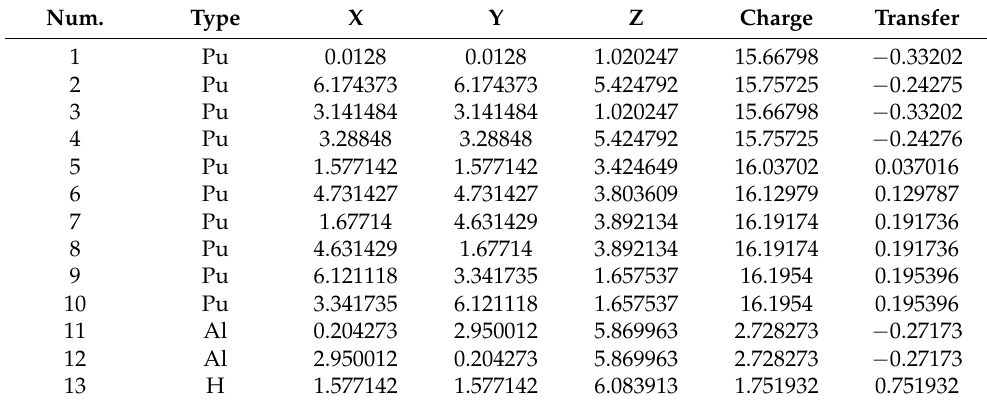
Table 4. Surface atomic charge transfer in Pu-Al system with H absorbed. Num.